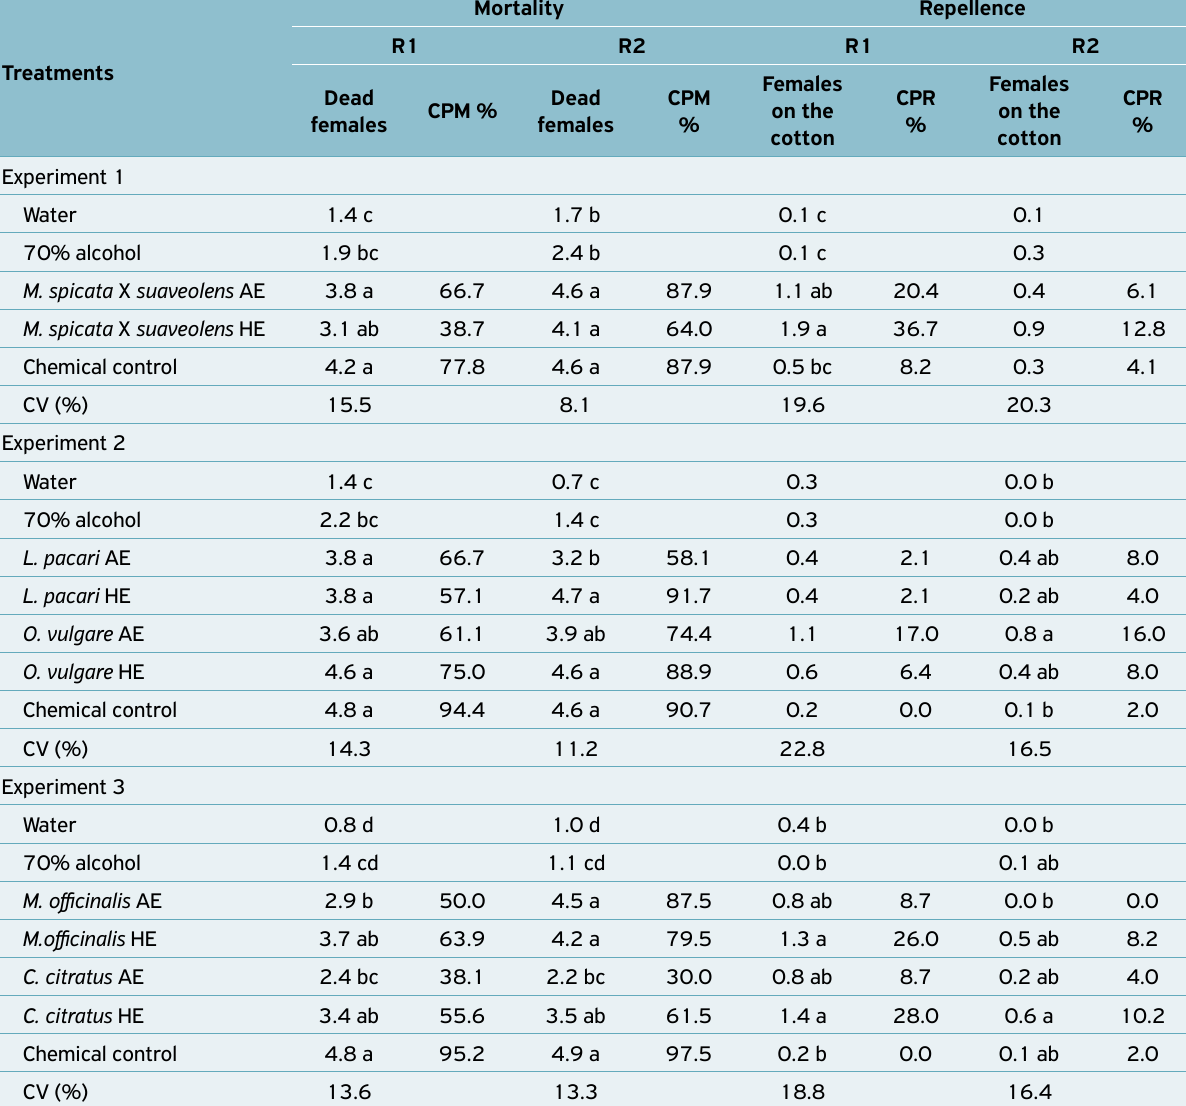
Table 2. Average number of Tetranychus urticae females dead and found on the cotton, corrected percentage mortality and corrected percentage repellency, 120 hours after spraying with plant extracts. Experiments 1 to 3, two replicates (R1; R2). Ilha Solteira, São Paulo,